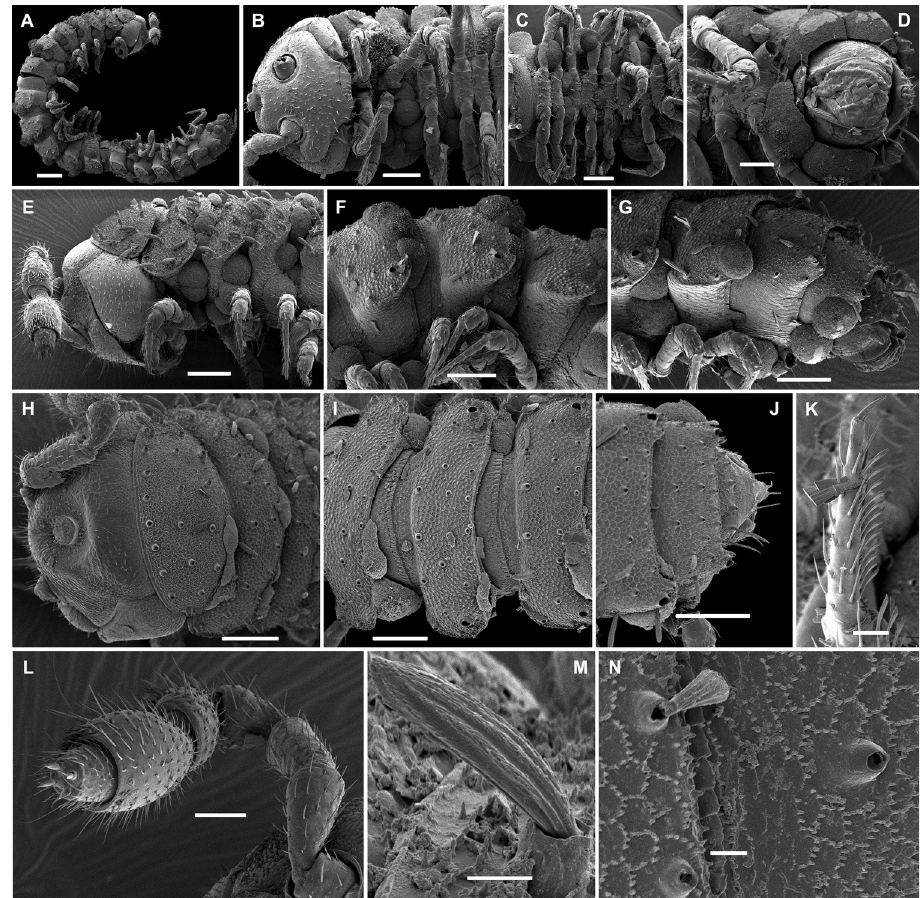
Figure 25. Hemisphaeroparia mouanko sp. n., SEM micrographs of ♂ paratype A habitus, lateral view B, E, H anterior part of body, ventral, lateral and dorsal views, respectively C, F, I midbody segments, ven- tral, lateral and dorsal views, respectively D, G, J posterior part of body, ventral, lateral and dorsal views, respectively K tarsus from anterior part of body, lateral view L antenna, sublateral view M bacilliform tergal seta, lateral view N tergal fine structure with a subclavate seta, dorsal view. Scale bars: 0.2 mm ( A ), 0.1 mm ( B, C, E–J ), 0.05 mm ( D, L ), 0.02 mm ( K ), 0.01 mm ( M, N